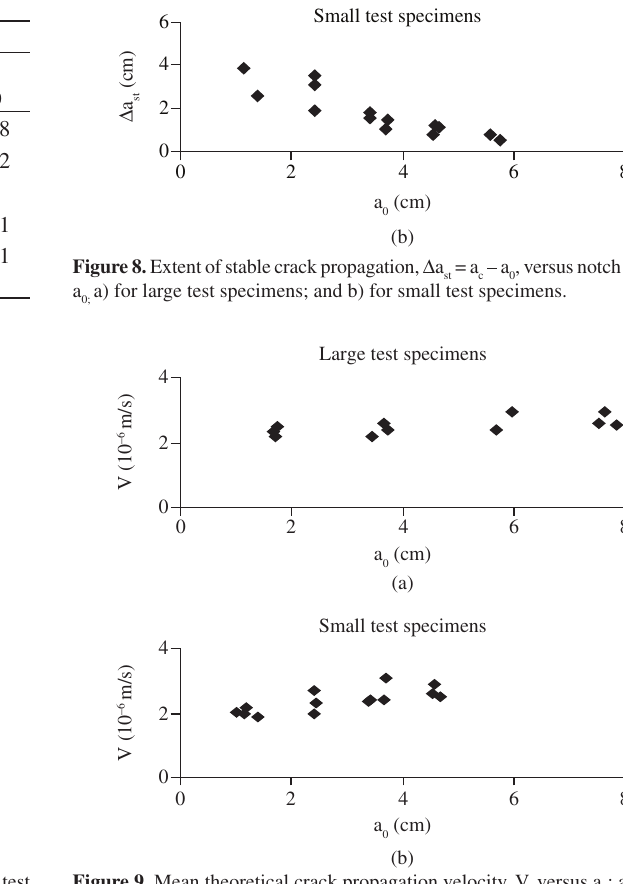
a) for large test Figure 9. Mean theoretical crack propagation velocity, V, versus a 0; test specimens; and b) small test